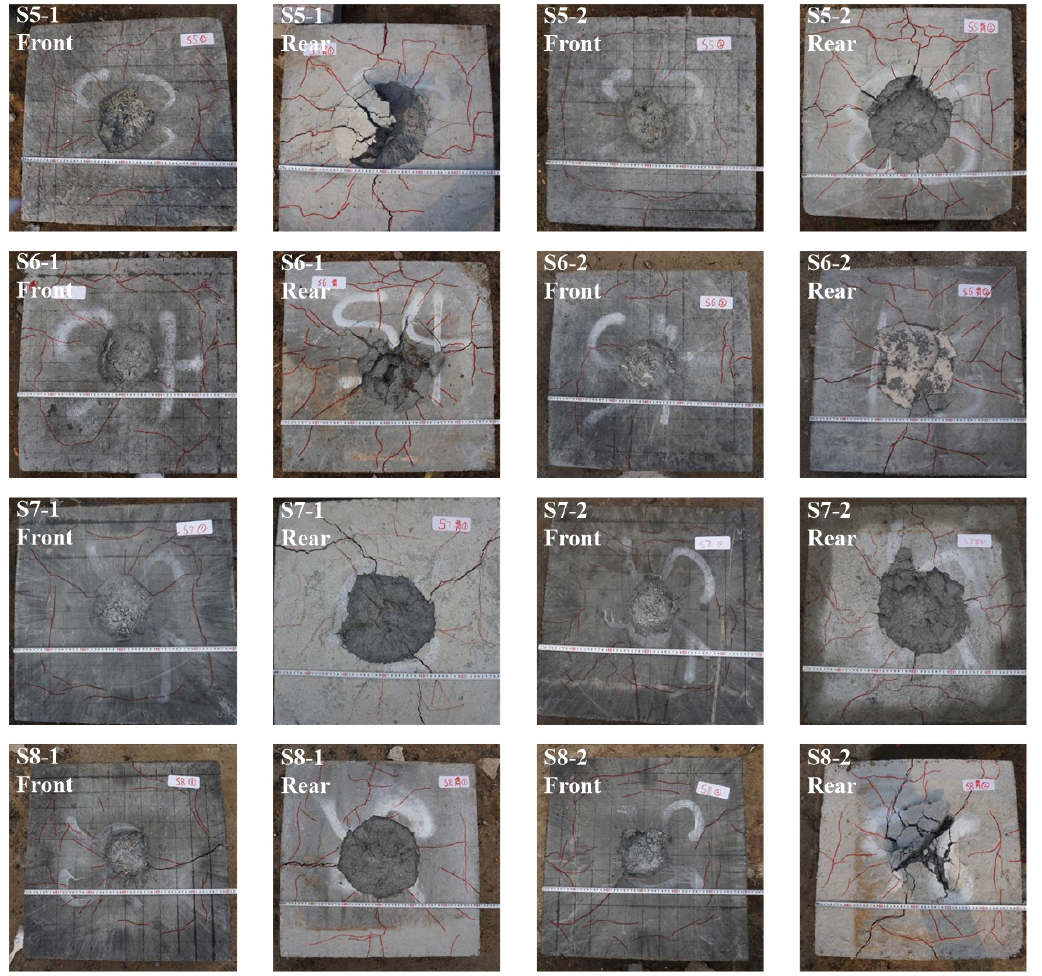
Figure 8. Damage mode of PP-Steel HFRC